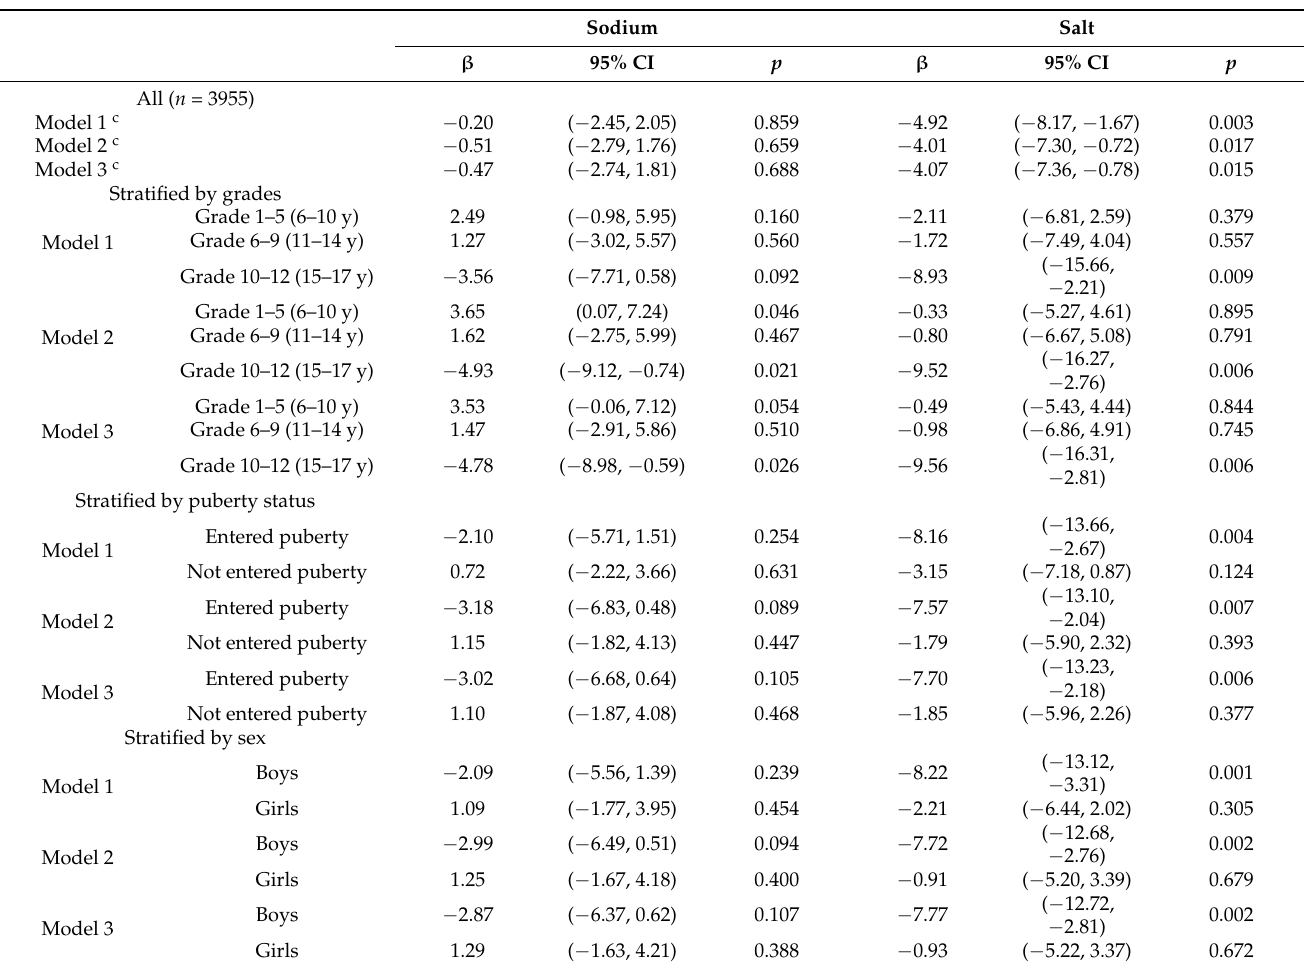
Table 4. Multiple linear regression analysis of total fluid consumption (g/d) and dietary sodium intake (390 mg/d)/salt intake (1 g/d) among all participants a,b